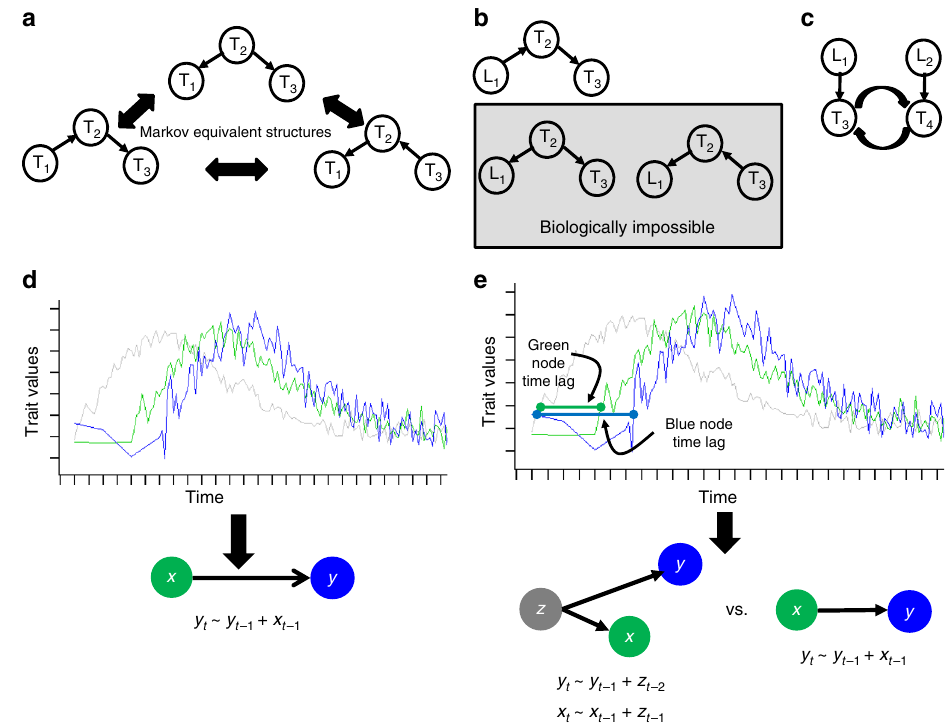
Fig. 1 Overview of causal relationships in complex biological systems. a Bayesian network is a directed graph. However, causal relationships cannot be unambiguously inferred from a directed graph due to Markov equivalent structures. b Systematic genetic perturbation data enables causality inference and causal network construction by eliminating biologically impossible structures. c Two traits are related via a feedback loop. d Time-series data provide information for inferring causality. e Time-series data alone are not suf fi cient for distinguishing causality and varied time delay. Additional information is needed to infer true causal